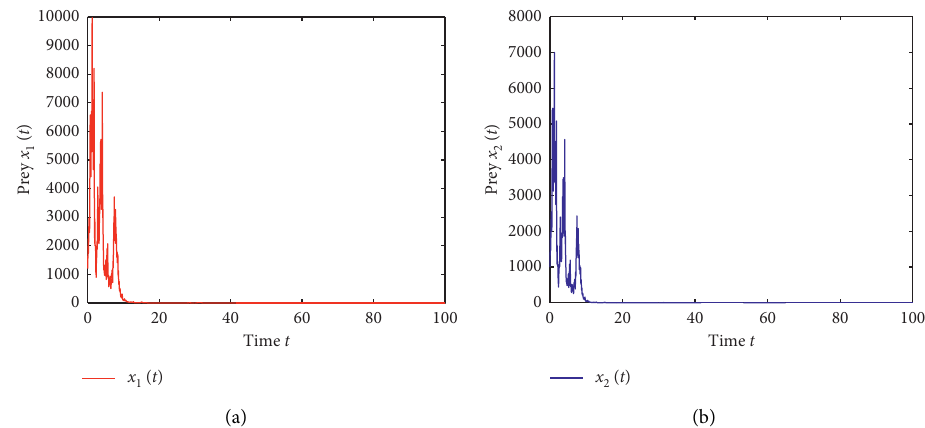
Figure 11: The trajectories of stochastic model (5) with σ 2 x ( t ) and (b) prey x 1